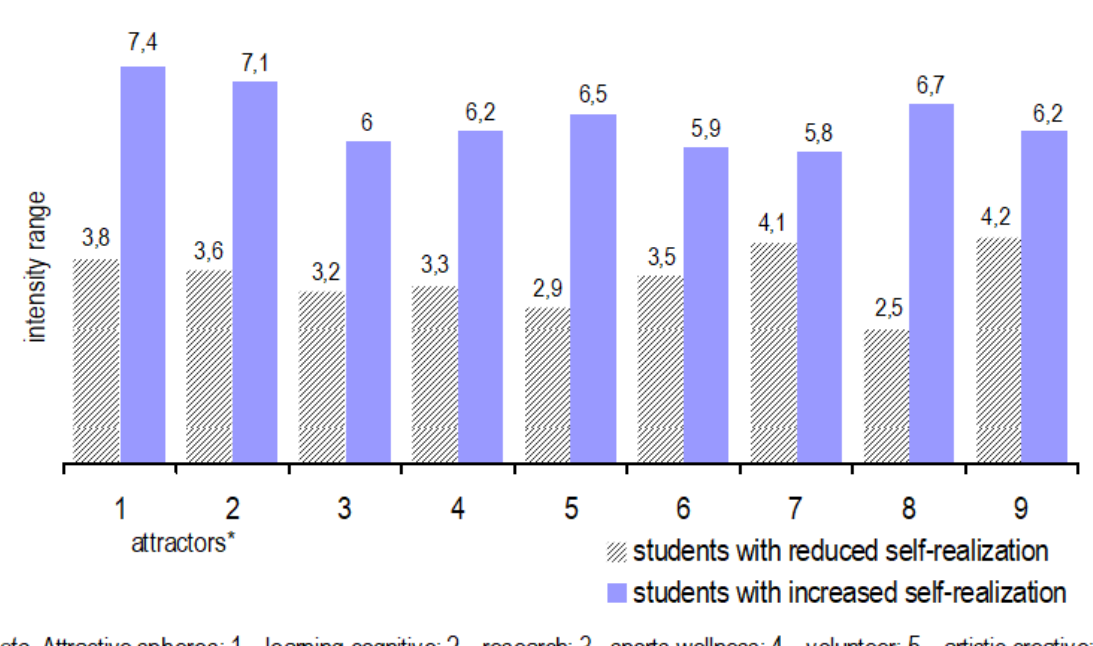
Figure 1. Summary data on the subjective significance of attractive spheres of University life for students with different levels of self-realization in